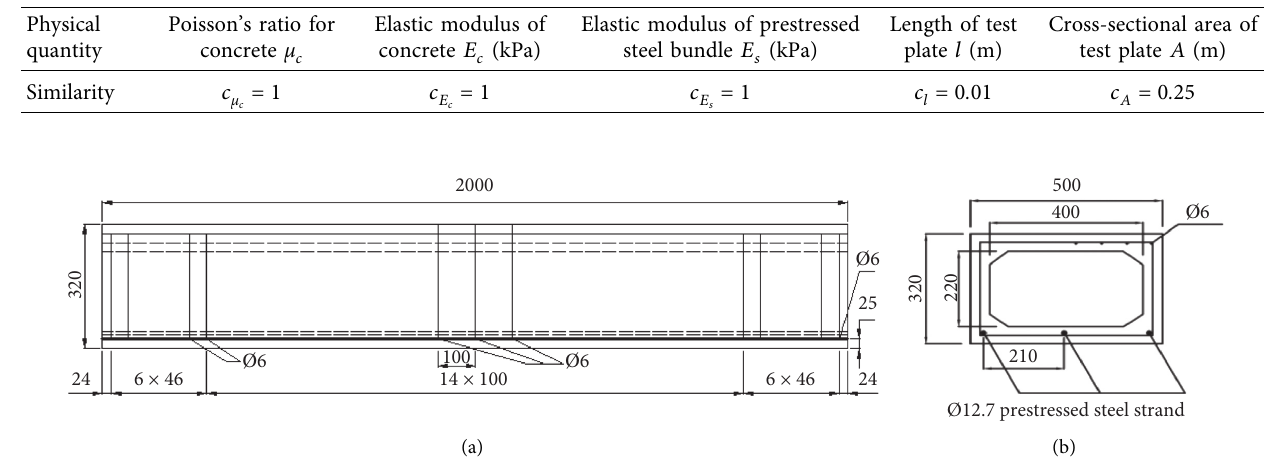
Table 1: Similarity coefficient of the test plate.